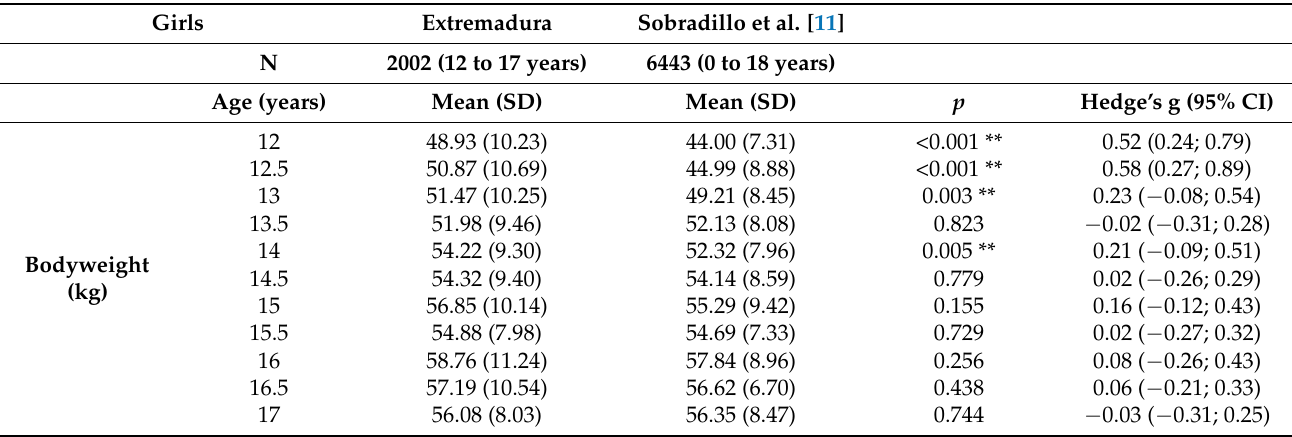
Table 3. Between-study comparison for bodyweight, height and BMI in